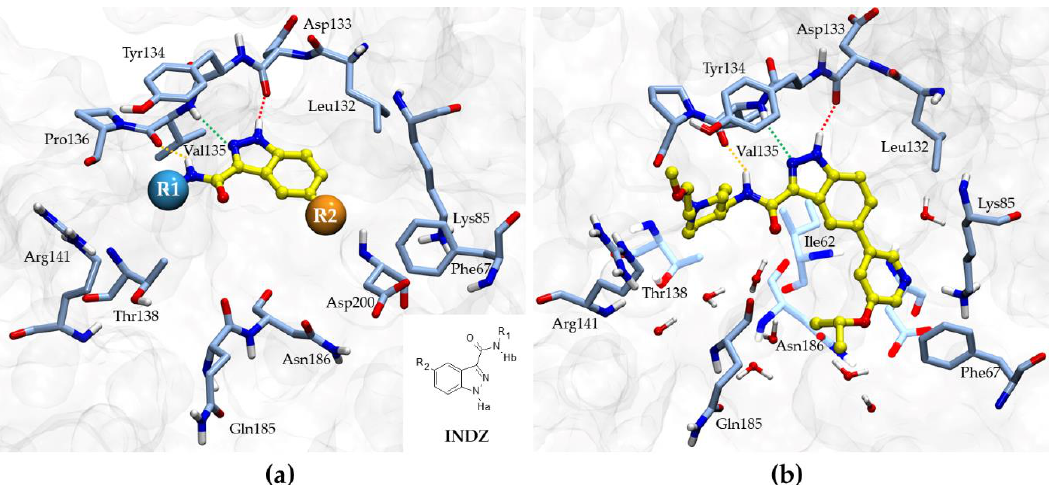
Figure 2. ( a ) Generic binding mode of the INDZ core in the ATP binding domain of GSK- 3β enzyme extracted from crystallographic studies discussed elsewhere [16,17,19]. The 2D structure of the INDZ core with explicit Ha and Hb atoms is also showed; ( b ) X-ray co-crystal structure of inhibitor 2 in complex with GSK- 3β enzyme (PDB entry 6Y9R). The deep, central and outer H-bond interactions are represented as red, green, and orange dashed lines, respectively. The most relevant residues of the ATP binding site are showed in light blue (for clarity, light transparency is used for some amino acids). Relevant water molecules around inhibitor 2 are also displayed. Both figures were prepared with VMD 1.9.4 [24].